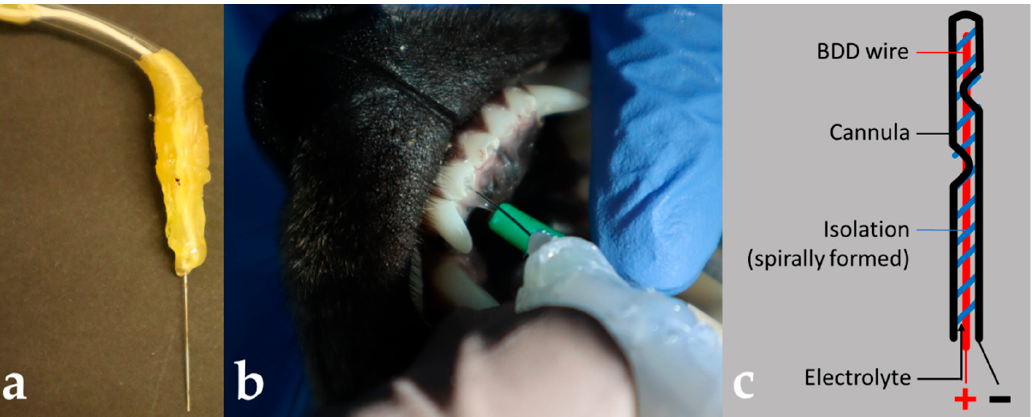
Figure 2. Canine tooth model for BDD electrode treatment using prototype 2. ( a ) Detailed view of prototype 2 electrode. A cannula wired as cathode was combined with an internally positioned BDD-coated niobium wire using insulating material. ( b ) Clinical situation showing the application of BDD electrode inside a root canal of a maxillary incisor. ( c ) Scheme of electrode with anode (+) and cathode ( −